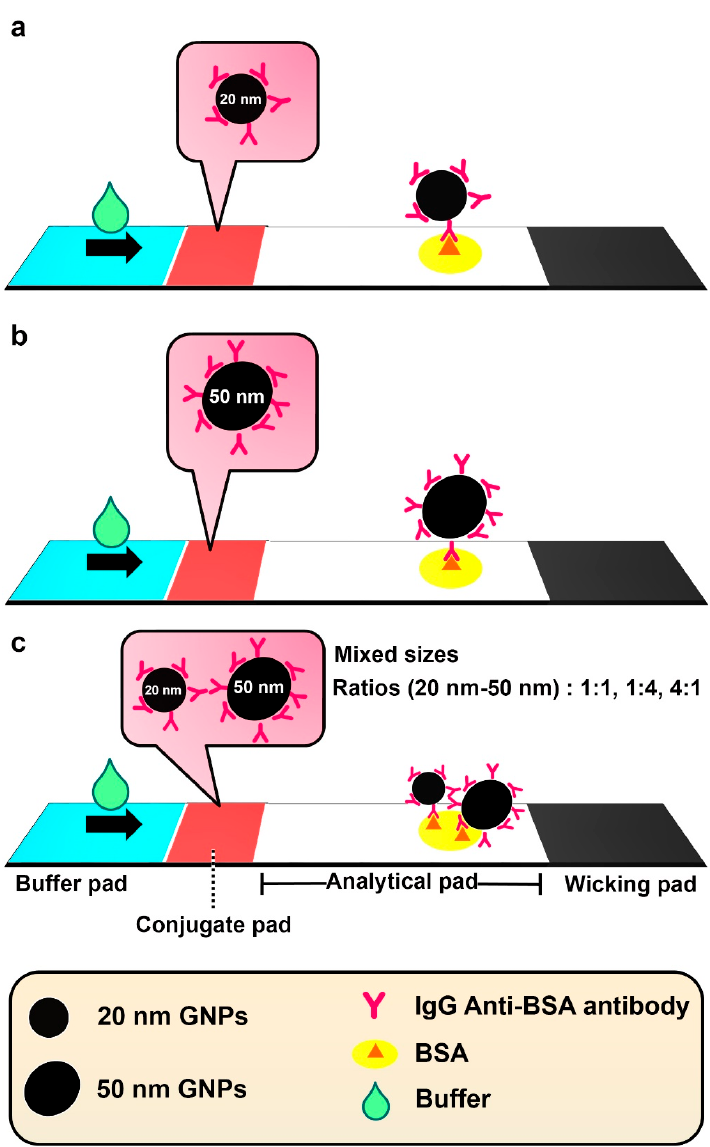
Figure 1. The schematic illustration of our proposed facile LFA strategy for BSA detection by employing GNPs conjugated with anti-BSA antibodies. Three GNP models were used: ( a ) single-sized (20 nm); ( b ) single-sized (50 nm); and ( c ) mixed-sized (20 nm and 50 nm) GNPs.